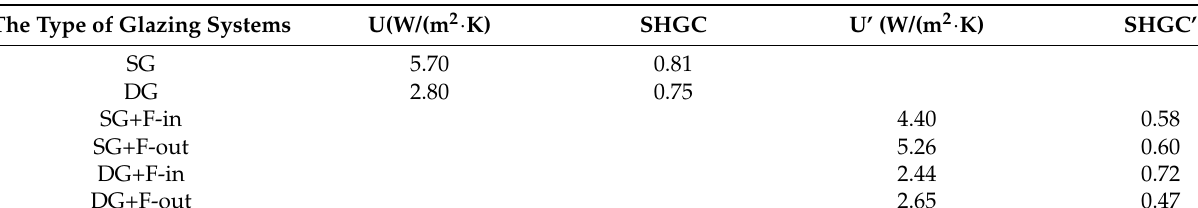
Table 2. The thermal parameters of glazing systems.